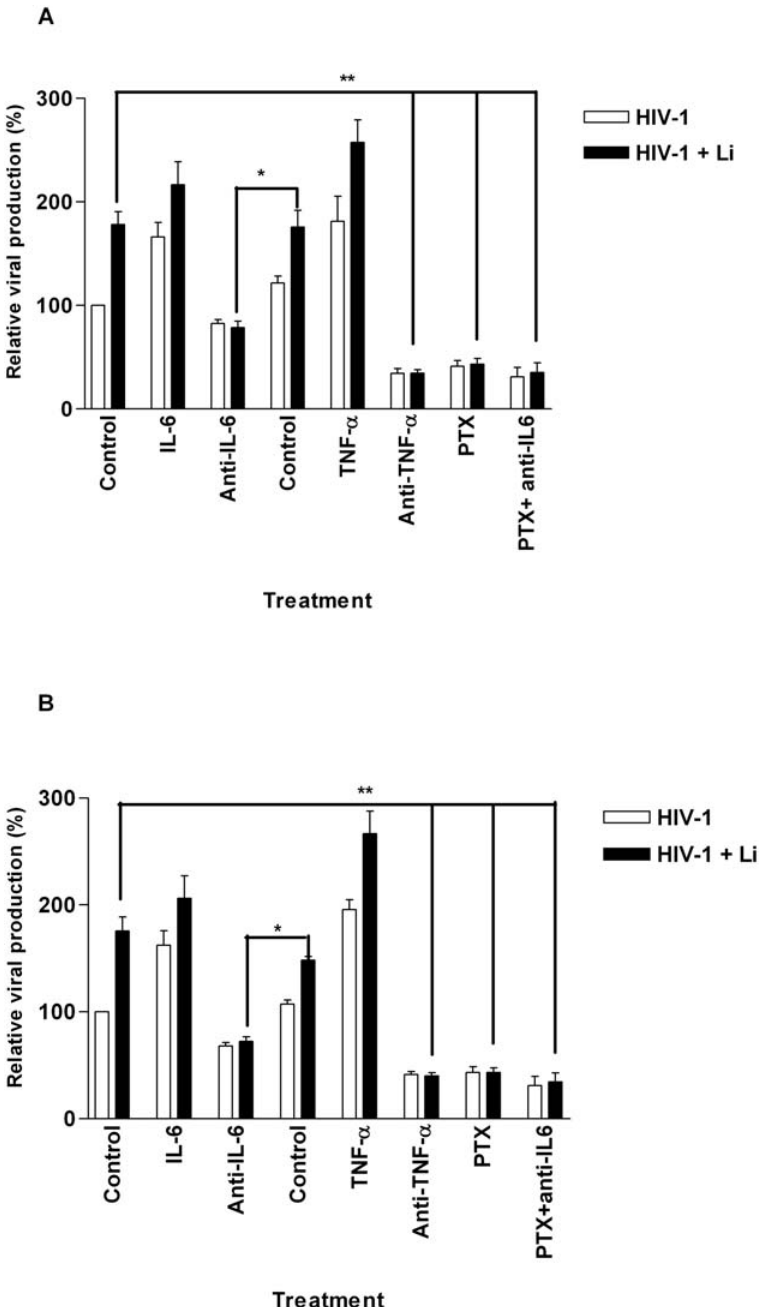
Figure 7. Parasite-mediated enhancement of virus replication in cocultured cells is due to IL-6 and TNF- a . First, iDCs were pulsed for 60 min with NL4-3Bal env and either left unexposed or exposed to Leishmania infantum amastigotes (Li). Next, iDCs were cocultured with autologous CD4 + T cells (A) or cultured alone (B) and either left untreated or treated with the listed reagents (IL-6, 10 U/ml; anti-IL-6, 10 m g/ml; isotype-matched control antibody, 10 m g/ml; TNF- a , 10 ng/ml; anti-TNF- a , 500 ng/ml; and PTX, 100 m M). Virus production was estimated by measuring p24 levels in the culture supernatants either at 4 days following initiation of the coculture (A) or at 6 days post-infection (B). The results shown are representative of four separate experiments performed with different donors and are expressed as relative viral production compared to untreated iDCs. Asterisks denote statistically significant data (*, P , 0.05; **, P , 0.01).